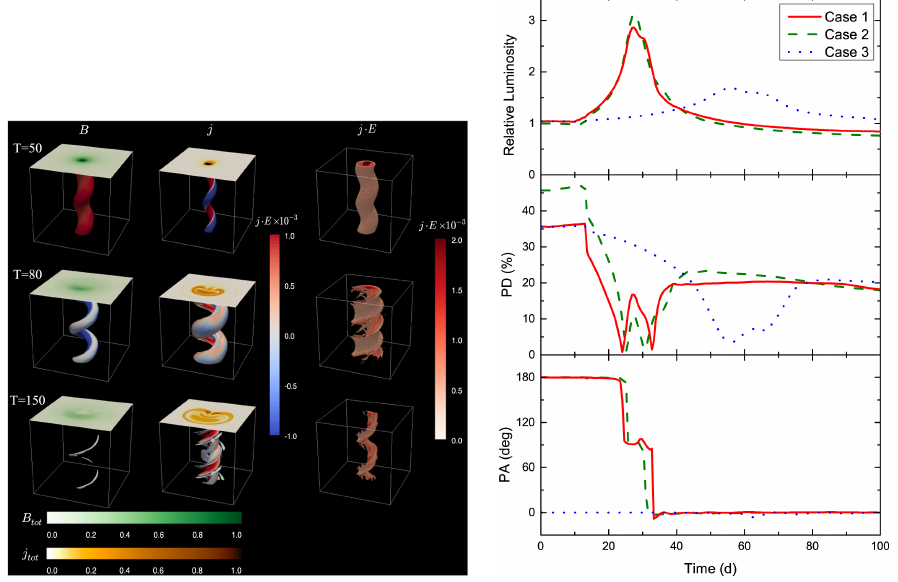
Figure 18. Left : Magneto-Hydrodynamics (MHD) simulations of the evolution of the kink instability in a blazar jet. Right : The resulting (top) light curves, (middle) polarization degree, and (bottom) polarization-angle swing. The simulation in the left panel corresponds to Case 1 in the right panel, corresponding to a magnetization of σ m = 2. For Case 2, the initial helical B-field is radially more strongly confined; for Case 3, the magnetization is lower ( σ m = 0.2) compared to Case 1. From [133]. Reproduced with permission from the American Astronomical Society (AAS).